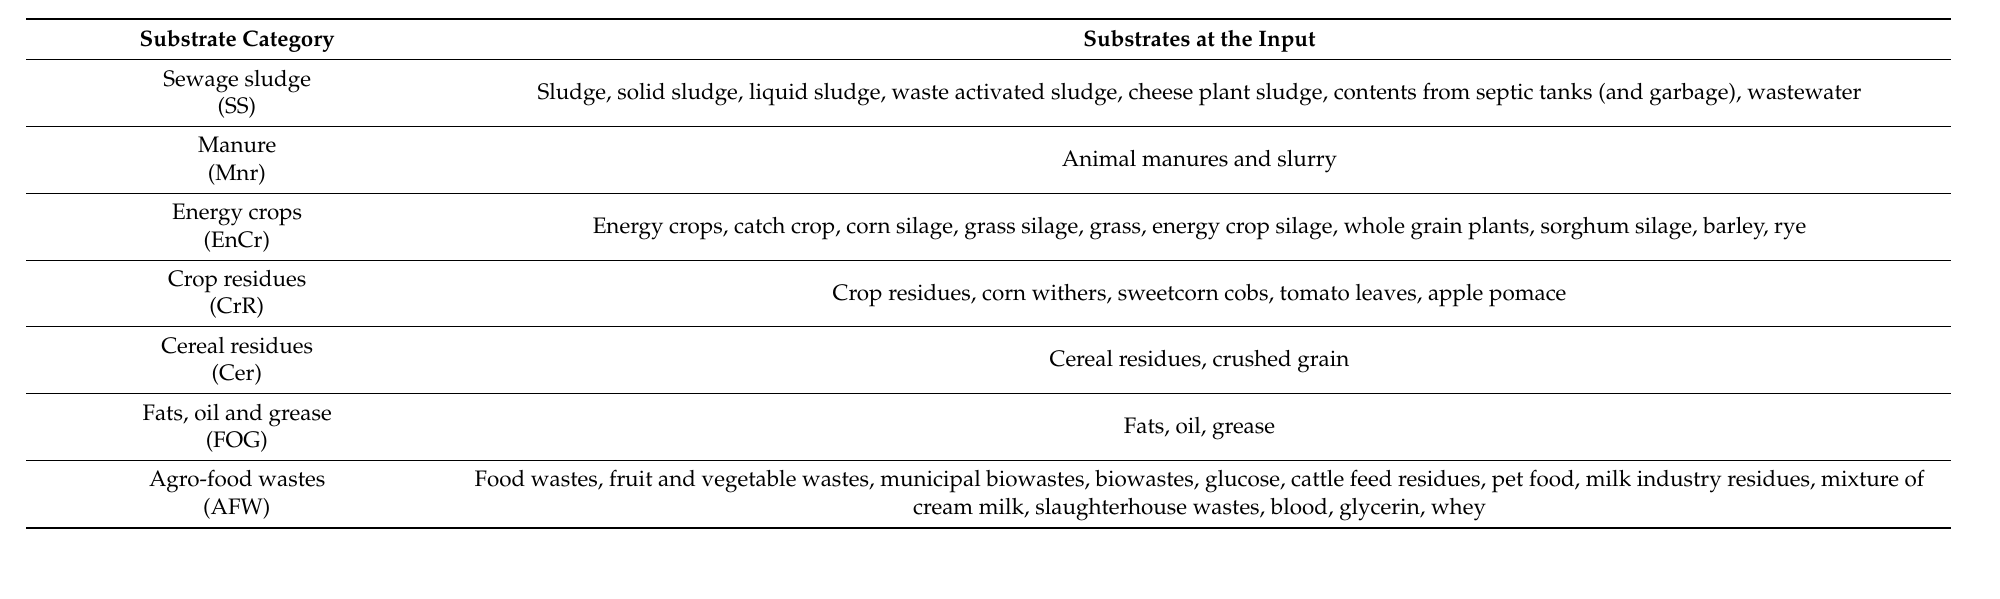
Table A1. Substrate categories based on substrates at the